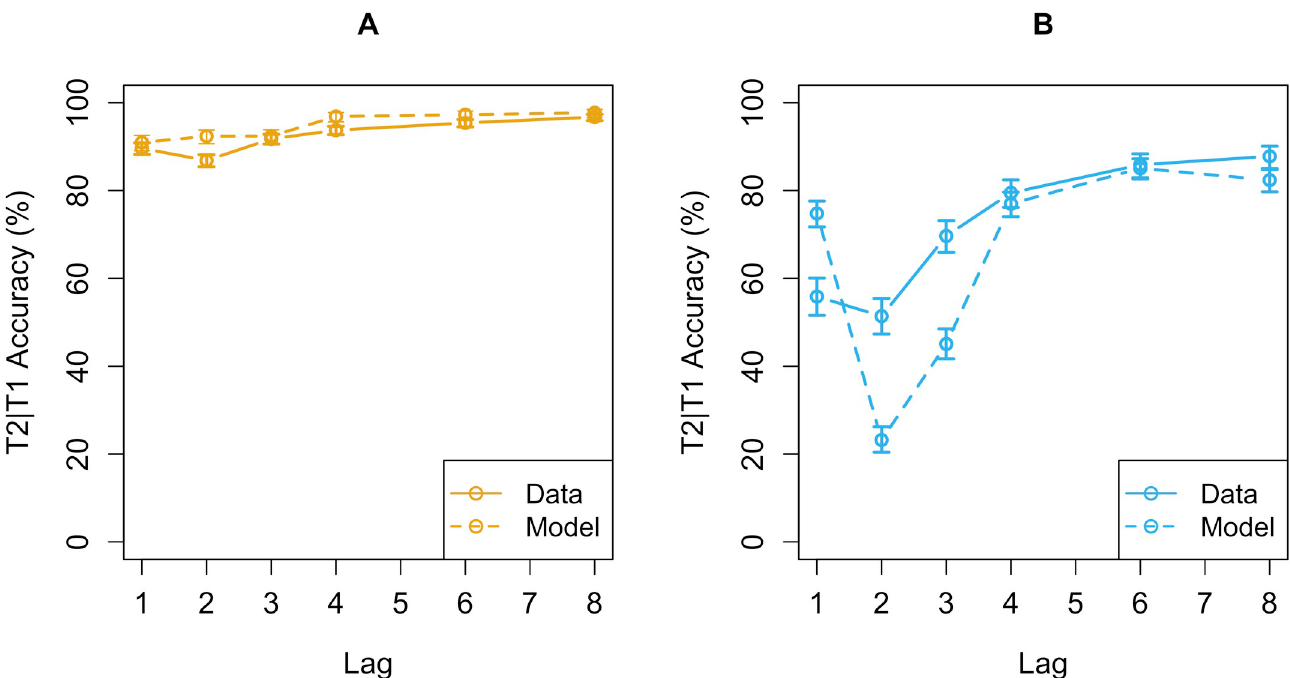
Fig 9. Model predictions and participant data for Cluster 1 and Cluster 2. (a) the predictions of the ‘consolidate-chunked’ version of the AB model (dashed orange line) which lines up well with the performance of the participants from Cluster 1 (solid orange line). (b) the predictions of the ‘consolidate-separate’ version of the model (dashed blue line) and the performance of the participants in Cluster 2 (solid blue line). Confidence intervals were calculated using the Agresti-Coull method [38].